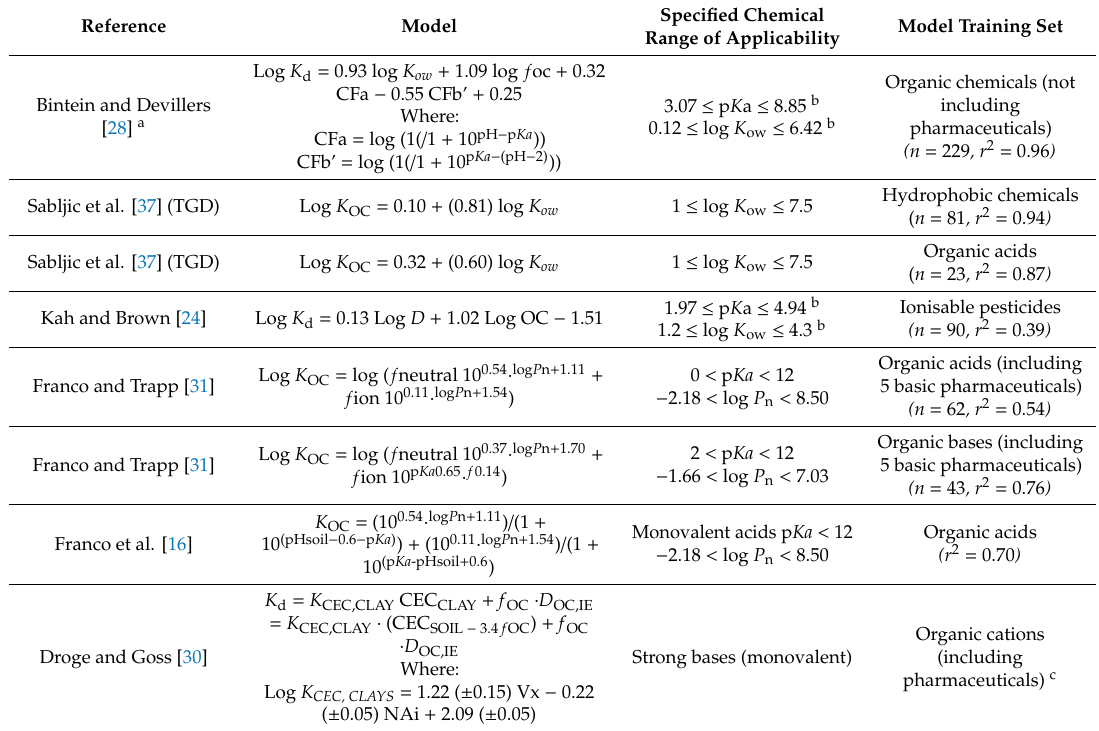
Table 1. Summary of soil sorption models selected for